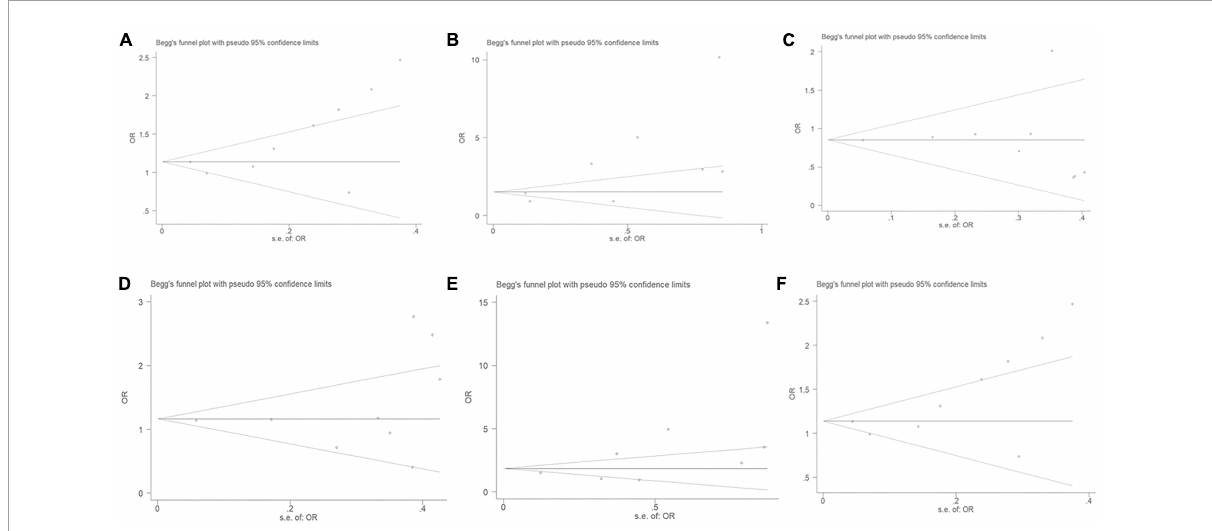
FIGURE7 The Begg’s funnel plot for studies of the association of CAD and MIF gene rs755622 G/C polymorphism. (A) The Begg’s funnel plot for studies of the association under an allelic genetic model (i.e., C allele vs. G allele + C allele of MIF gene rs755622 G/C polymorphism). (B) The Begg’s funnel plot for studies of the association under a recessive genetic model (i.e., CC vs. GG + GC of MIF gene rs755622 G/C polymorphism). (C) The Begg’s funnel plot for studies of the association under a dominant genetic model (i.e., GG vs. GC + CC of MIF gene rs755622 G/C polymorphism). (D) The Begg’s funnel plot for studies of the association under a heterozygous genetic model (i.e., GC vs. GG of MIF gene rs755622 G/C polymorphism). (E) The Begg’s funnel plot for studies of the association under a homozygous genetic model (i.e., CC vs. GG of MIF gene rs755622 G/C polymorphism). (F) The Begg’s funnel plot for studies of the association under an additive genetic model (i.e., C allele vs. G allele of MIF gene rs755622 G/C polymorphism). The horizontal and vertical axes correspond to the OR on log scale and SE(logOR), respectively. OR, odds ratio; SE, standard error.